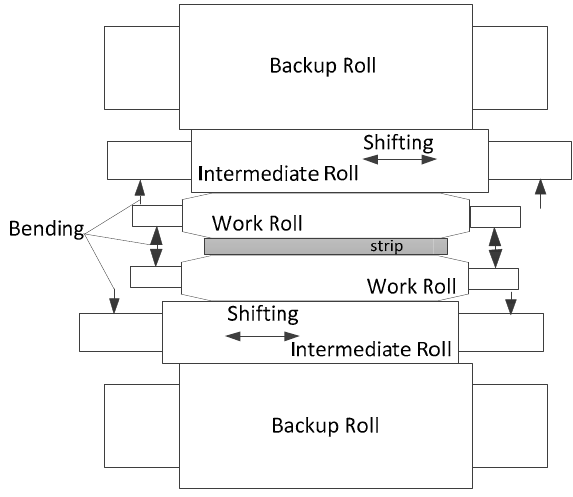
Figure 4. Rolls stack and strip system.